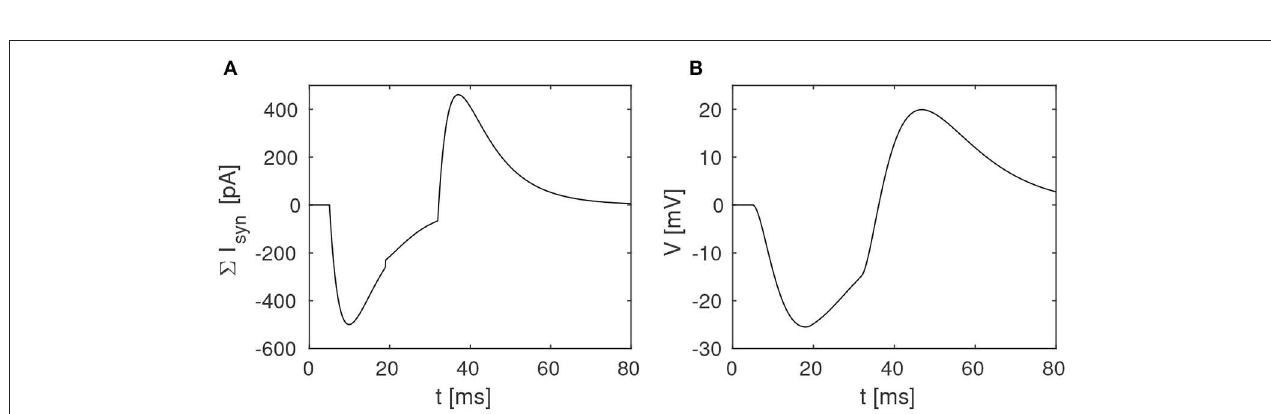
FIGURE 2 | Simulation of the disynaptic delay element model. (A) Sum of inhibitory and excitatory postsynaptic currents from the delay element. (B) Resulting postsynaptic neuron membrane potential.